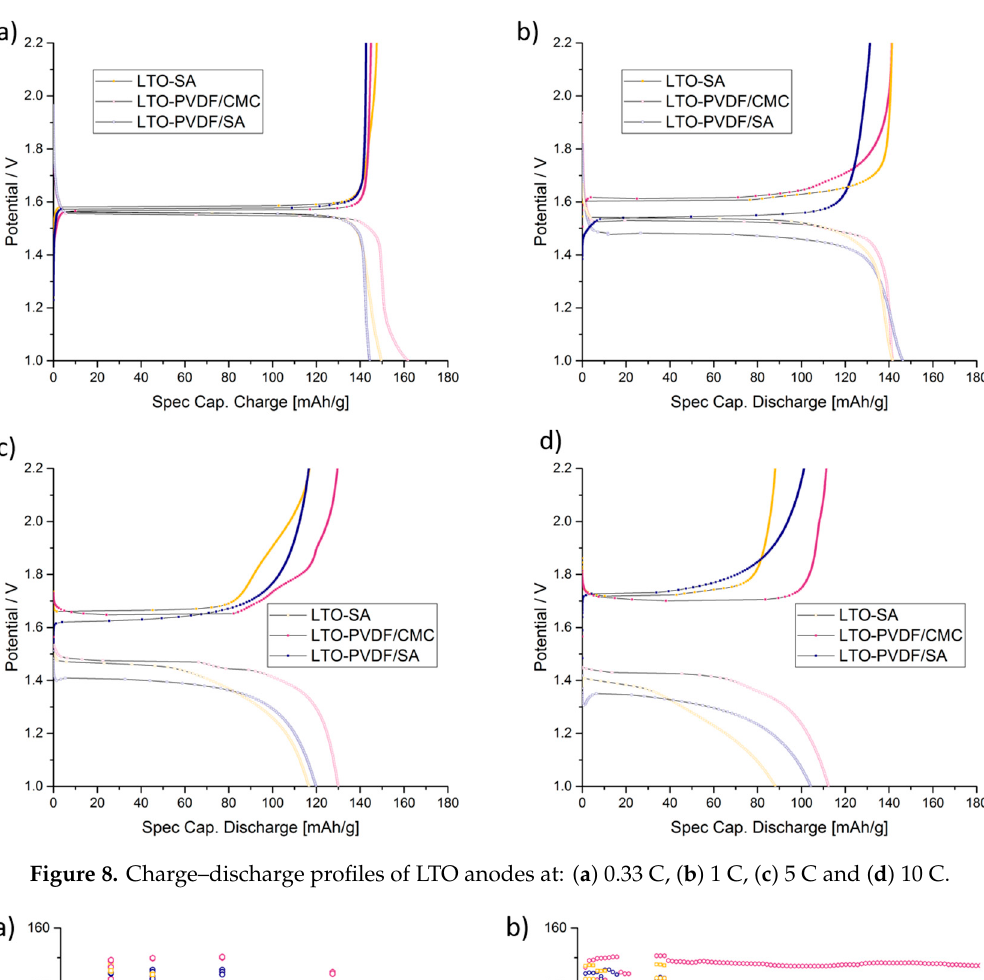
Figure 8. Charge–discharge profiles of LTO anodes at: ( a ) 0.33 C, ( b ) 1 C, ( c ) 5 C and ( d ) 10 C.